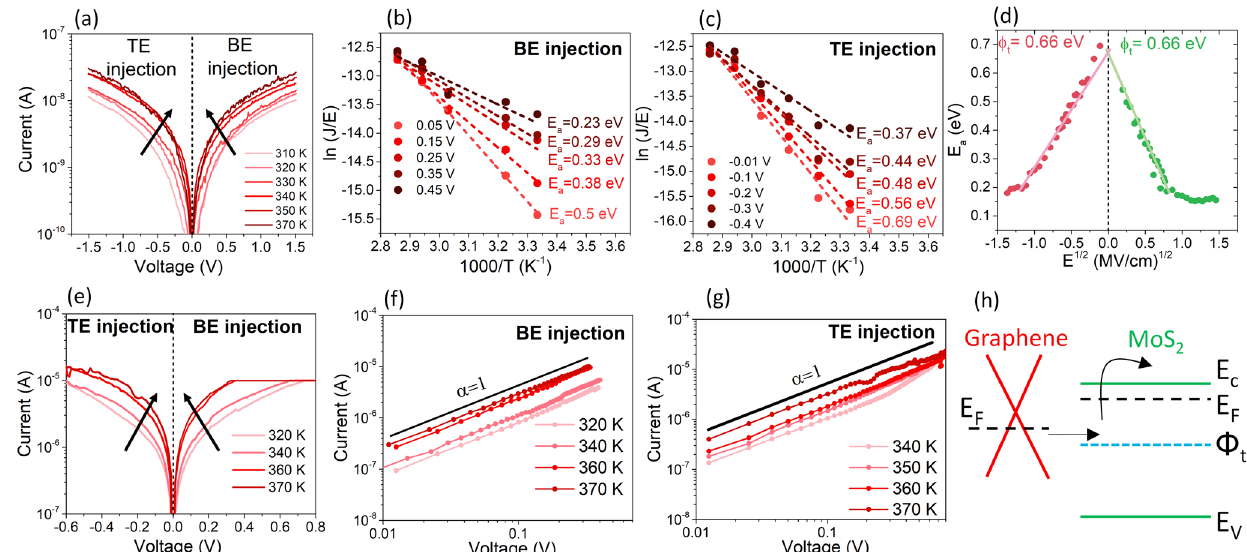
Fig. 5 Switching mechanism. a I-V characteristics of graphene / MoS 2 /SiO x device in HRS state where a clear temperature dependence is observed. b Arrhenius plot of the graphene / MoS 2 /SiO x device in HRS for bottom electrode injection following the PF model. c Arrhenius plot of the graphene / MoS 2 /SiO x device in HRS for top electrode injection following the PF model. d The extracted activation energy is plotted as the function of electric fi eld where the intercept at E = 0 gives the electron trap energy state. e I-V characteristics of graphene / MoS 2 /SiO x device at LRS states where a clear signature of temperature dependence is observed. f The double logarithmic plot of I-V at LRS state for bottom electrode injection indicating ohmic conduction. g The double logarithmic plot of I-V at LRS state for top electrode injection indicating ohmic conduction. h The band diagram of the graphene / MoS 2 /SiO x device showing the mechanism of switching in these